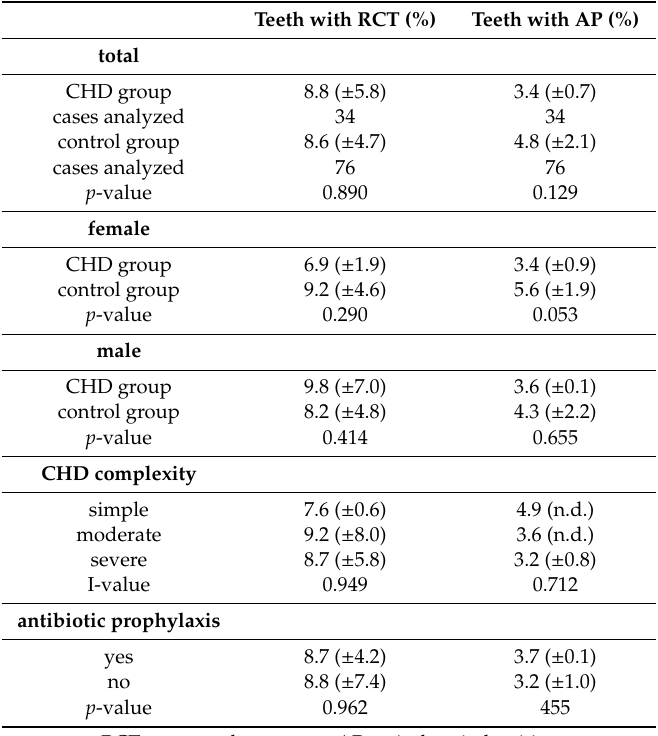
Table 5. Amount of teeth with previous root canal treatment and apical periodontitis among patients with CHD and healthy control subjects. Analysis of di ff erences between groups has been done with Mann–Whitney test, analysis between subgroups (CHD complexity) with Kruskal–Wallis